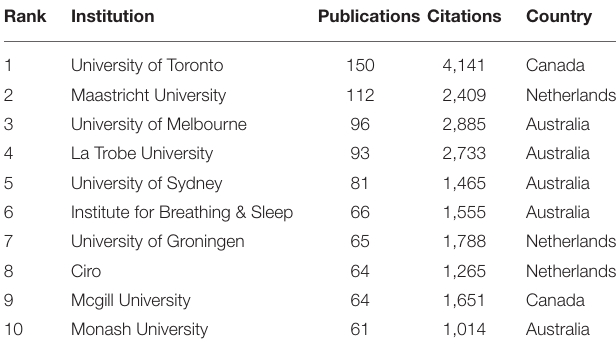
FIGURE 5 | The co-authorship network map of institutions for the research on pulmonary rehabilitation. TABLE 3 | Top 10 publications of institutions related to pulmonary